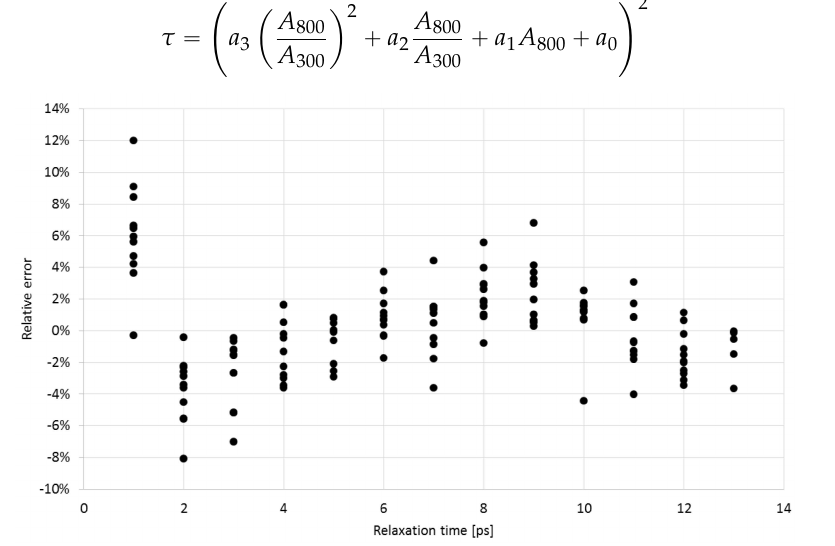
Figure 9. The relaxation time relative error determined from Equation (2) for the simulated materials.